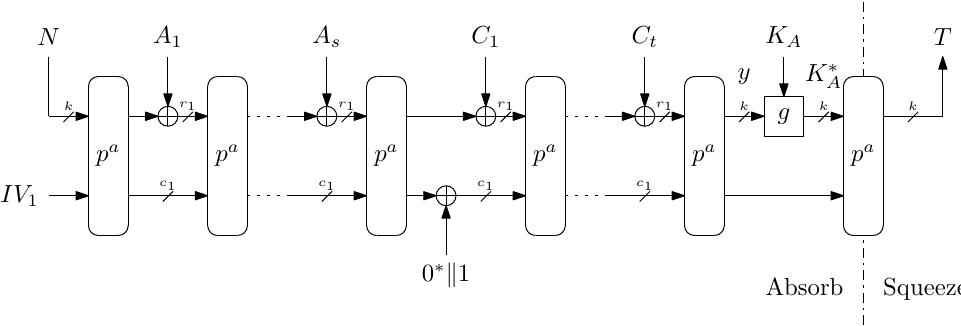
Figure 2: IsapMac used for authentication.